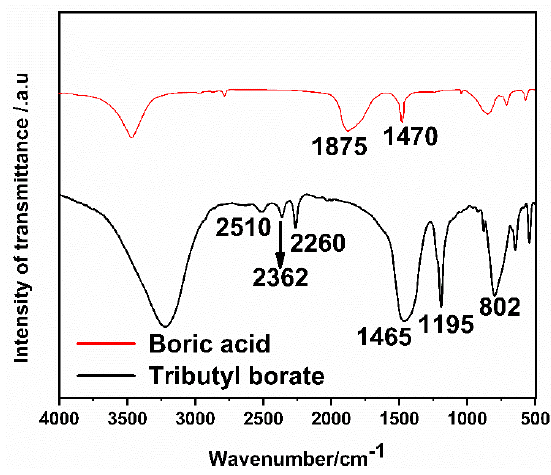
Figure 2. FT-IR spectra of tributyl borate.